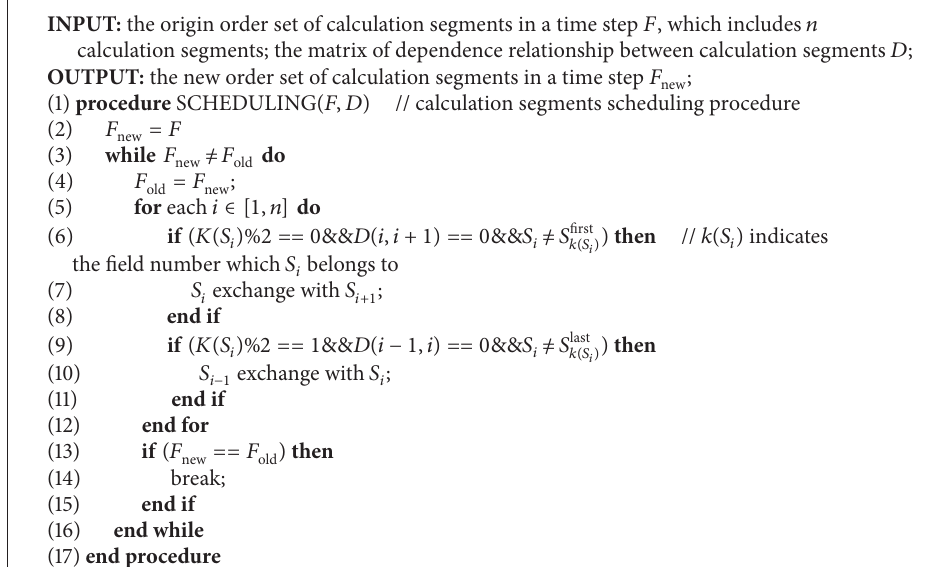
Algorithm 1: A heuristic algorithm for the scheduling of fields’ calculation segments in a single timestep.